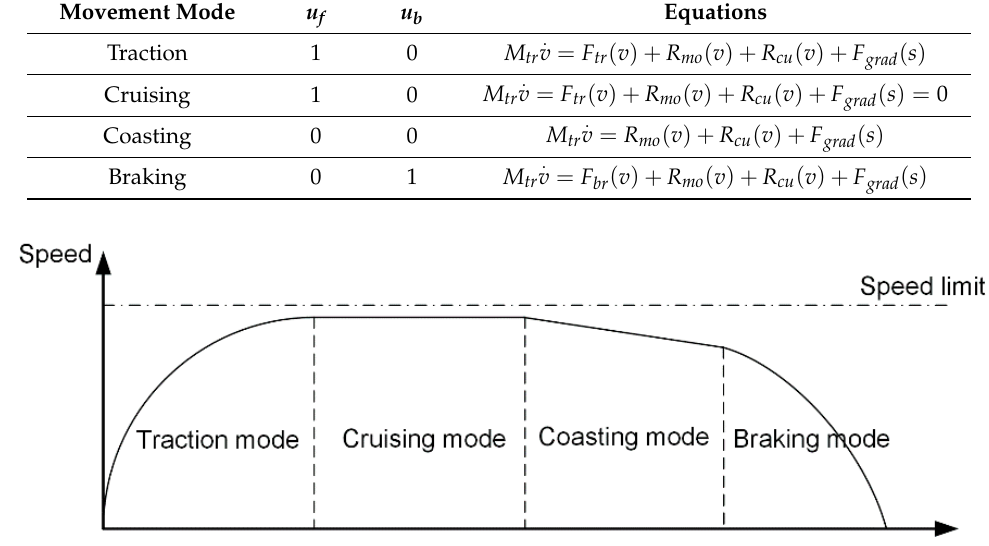
Figure 3. Four train movement modes.